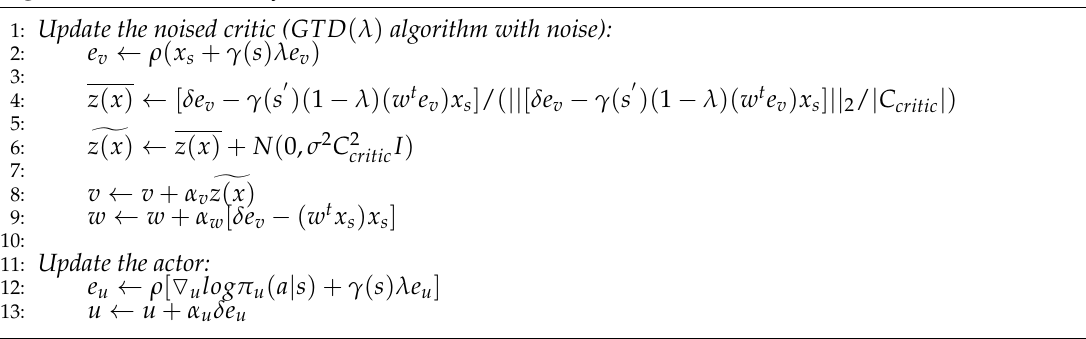
Algorithm 3 Differentially Private Critic (DP-Critic)